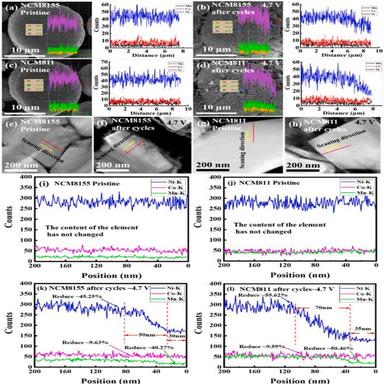
SEM-EDS line scan analysis of the secondary particle cross-sections of NCM8155 and NCM811 original materials (a, c) and 4.7 V voltage cycles (b, d); TEM images of the primary particle cross-sections (e–h) and STEM-EDS line-scan analysis patterns of each along the radial direction (i–l).